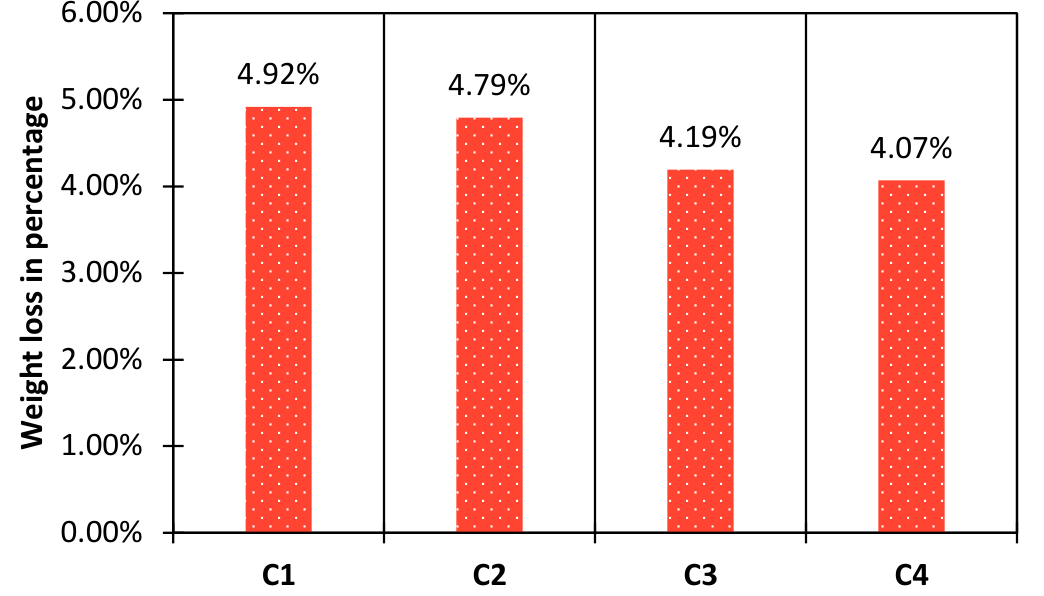
Figure 30. Percentage of weight loss in the specimens.